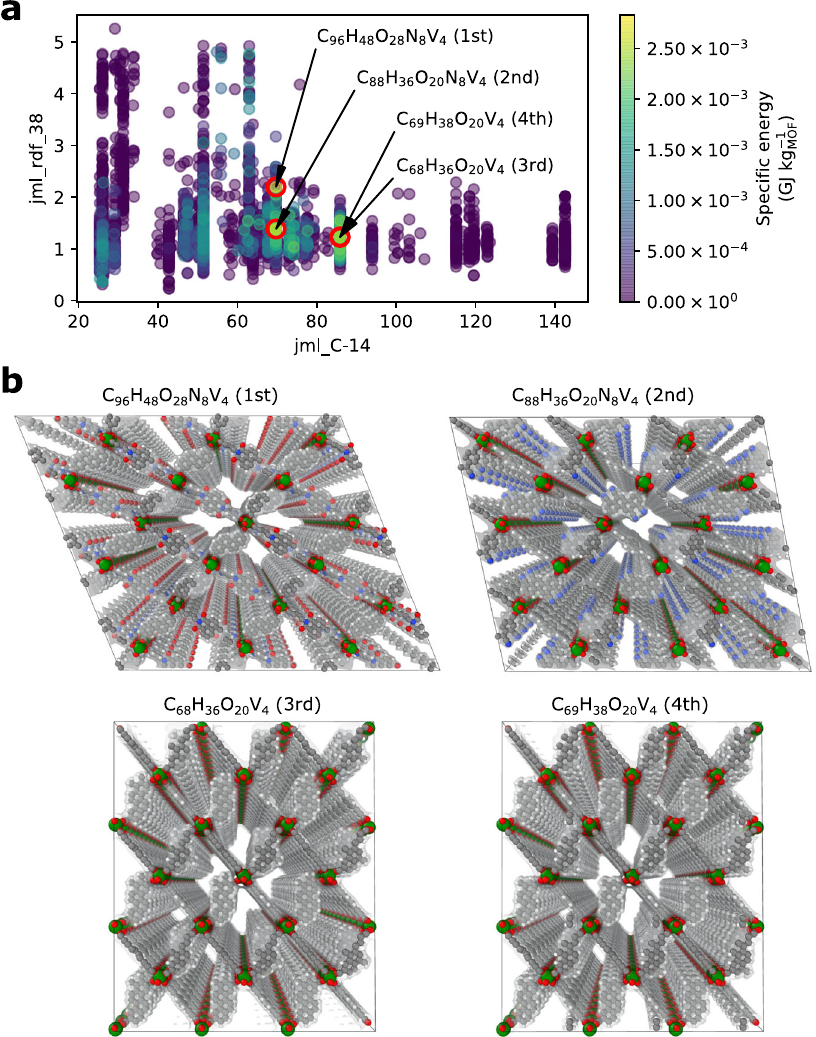
Fig. 6 Hypothetical MOFs ranked with respect to the speci fi c energy. a 2D chart with the entire set of 5028 hypothetical MOFs in the database by Boyd et al. 46 , where the fi rst two SHAP ranked descriptors for the H 2 O Henry coef fi cient are represented and the best four MOFs sorbents for the adsorption/desorption based thermal storage application are highlighted. b 3 × 3 × 13 replications of the respective crystallographic cells (C atoms: gray; H atoms: white; O atoms: red; N atoms: blue; V atoms: